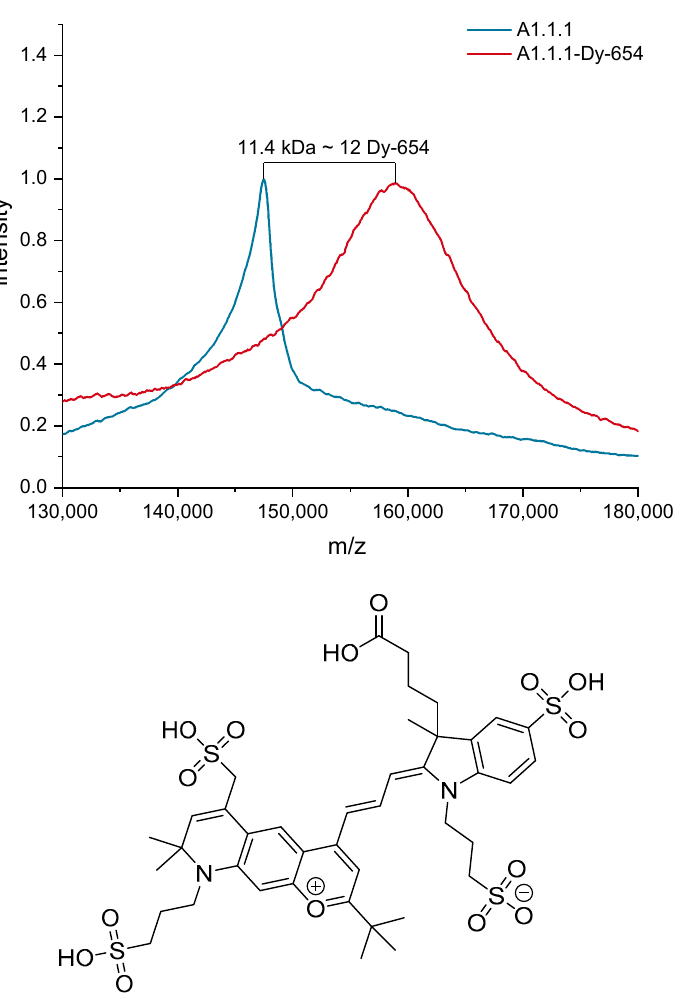
Figure 4. Smoothed MALDI-TOF MS spectra of the antibody A1.1.1 and the conjugate with the fluorescent dye Dy-654 (top) and structure of the label Dy-654-COOH (MW 1007.08 g/mol, Dyomics).